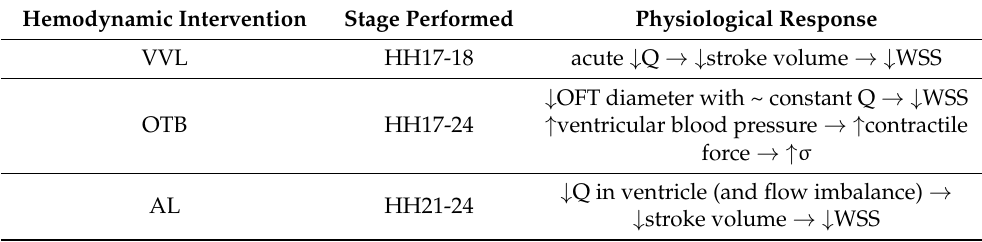
Figure 6. Hemodynamic interventions performed on chick embryos. ( A ) A surgical suture (or clip) is placed and tightened around one of the two vitelline veins that feed the heart at HH17-18. ( B ) A surgical suture is placed and tightened around the heart OFT at HH17-24. ( C ) A surgical suture (or clip) is placed and tightened around the left or right portion of the developing atria at HH21-24. VVL: vitelline vein ligation; OTB: outflow tract banding; AL: atrial ligation: RVV: right vitelline vein; LVV: left vitelline vein; OFT: outflow tract; V: ventricle, LA: left atria, RA: right atria. Table 1. Hemodynamic consequences of surgical interventions in chicken embryos. Hemodynamic Intervention